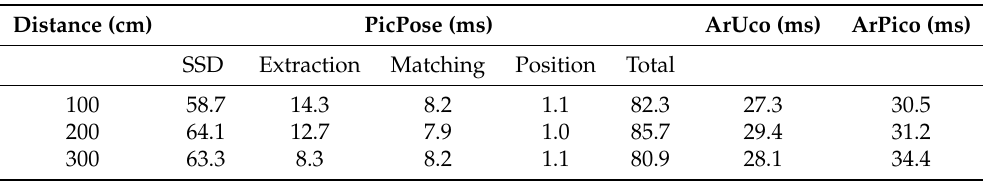
Table 5. Localization Execution